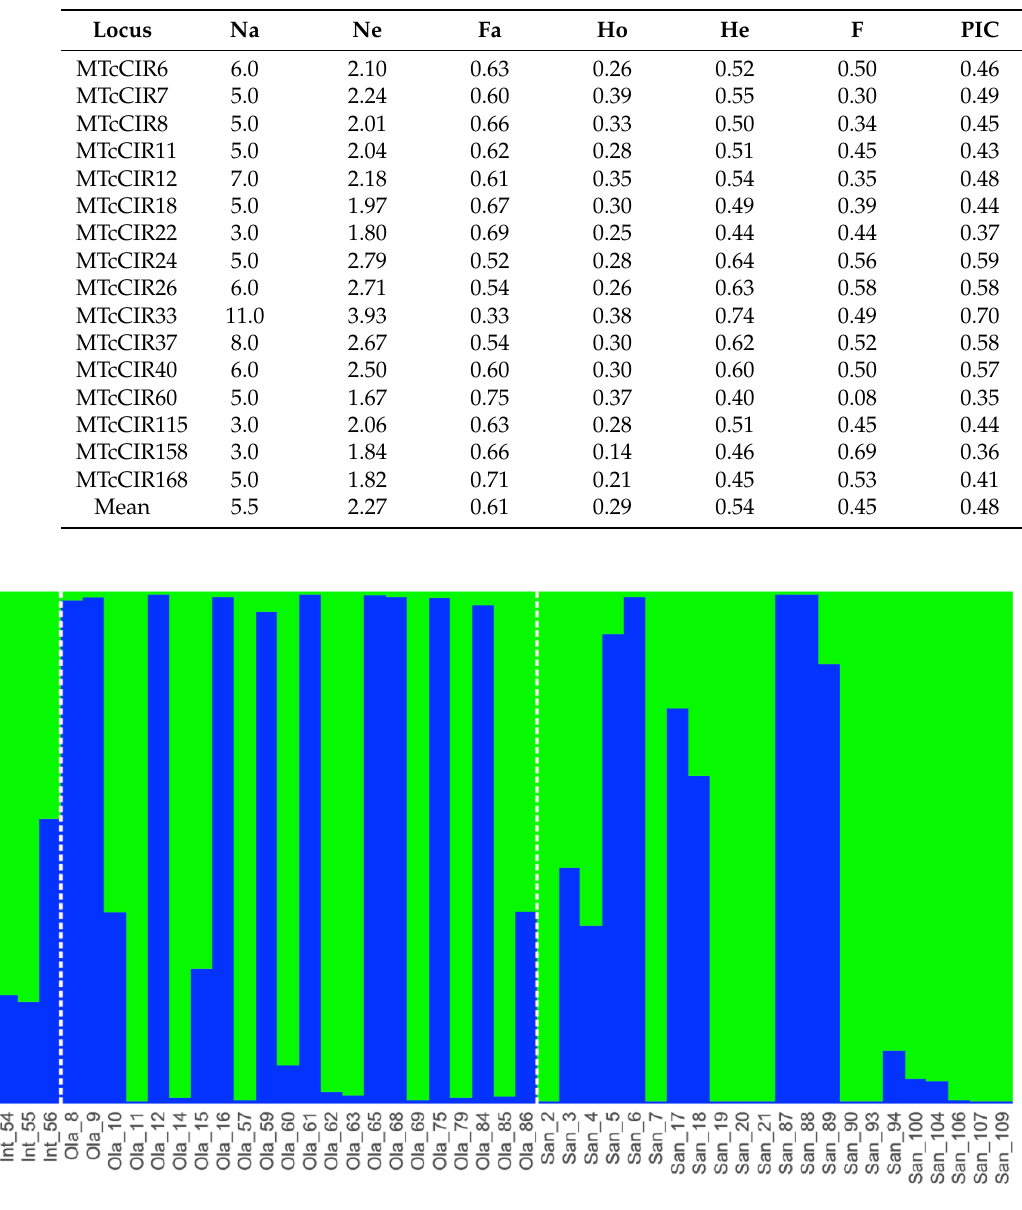
Table 2. Genetic parameters from 16 SSR loci. For each locus, the number of alleles (Na), the effective number of alleles (Ne), frequency of the predominant allele (Fa), the observed (Ho) and expected heterozygosity (He), the fixation index (F), and the polymorphic information content (PIC) of the “Honduras” dataset are shown.